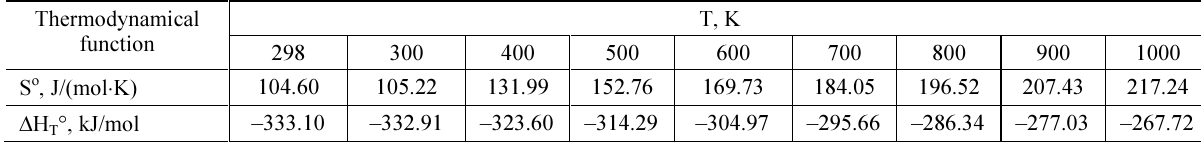
T, K Thermodynamical